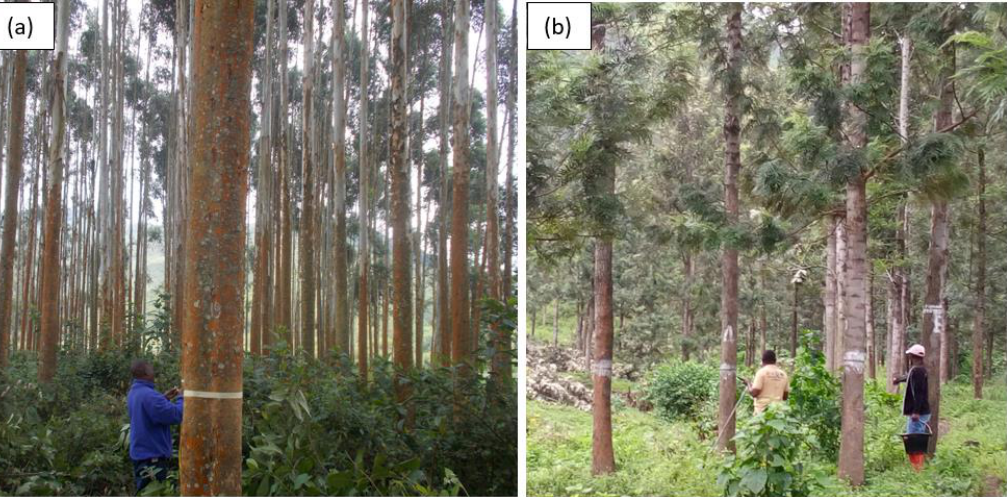
Photo 1. Nine-year-old E. saligna ( a ) and 8-year-old G. robusta ( b ) plantations in North Kivu. Diameter measurement levels were marked with paint at a height of 1.3 m or 30 cm above the defect, as appropriate.